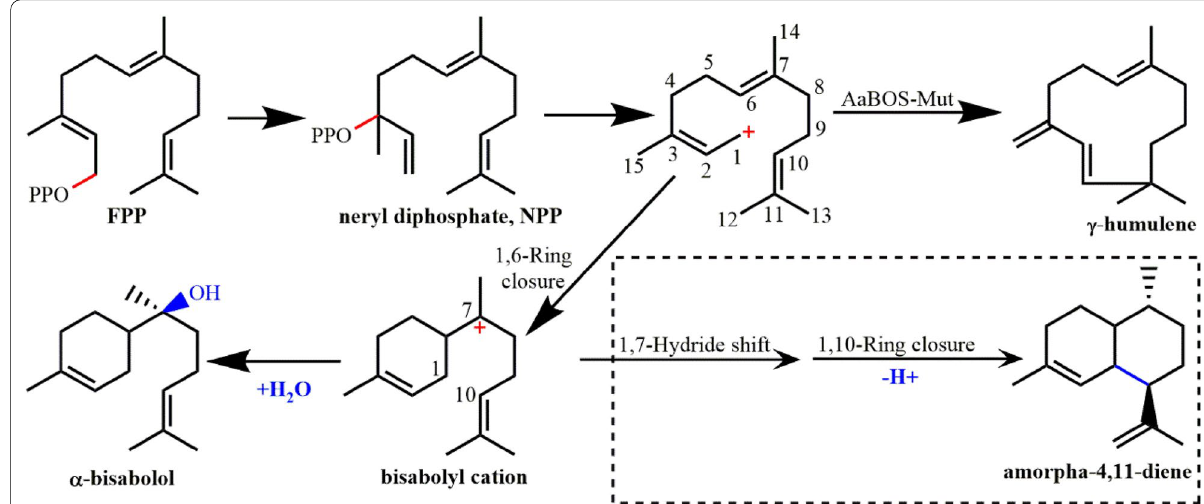
Fig. 9 Cyclization reaction catalyzed by α‑bisabolol synthase from Artemisia annua ( Aa BOS). Dashed box shows the reaction catalyzed by amorphadiene synthase. Aa BOS‑Mut represents the Aa BOS mutant (V373N/L381A/I395V/N398I/L399T) (Li et al.